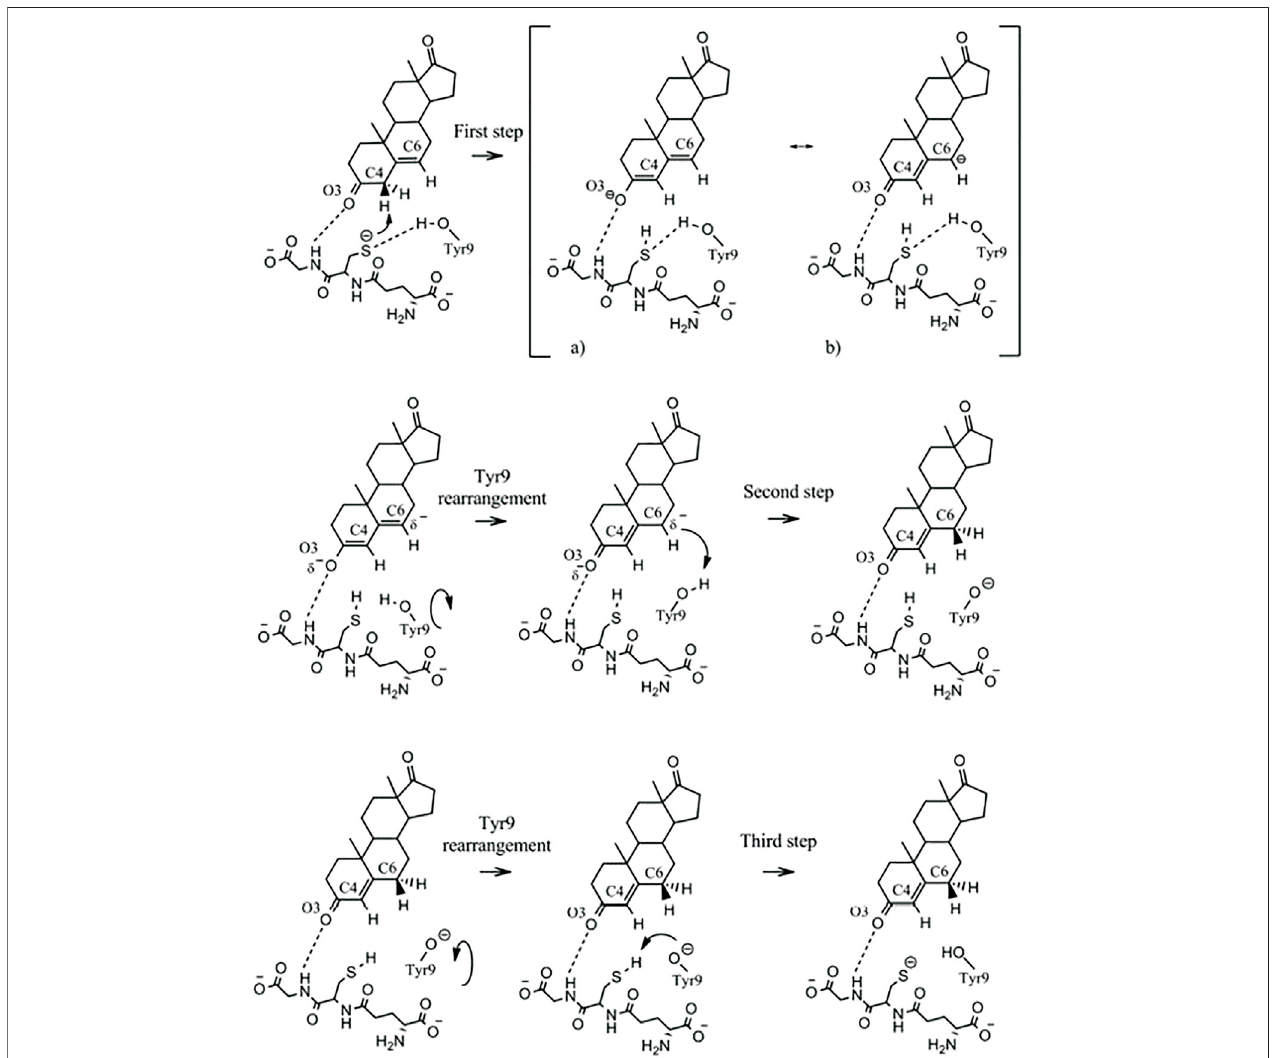
FIGURE 3 | Mechanism proposed for the isomerization of 5-androsten-3,17-dione by GST A3-3. Formation of the thiolate, which acts as a base, requires the α -carboxylate ofGluintheglutathionemolecule. TheNH ofGlyinglutathionepolarizestheO (cid:2) C3bondofthesteroid.ThehydroxylgroupofTyr9intheactivesiterotates between the sulfur of glutathione and C6 of the steroid substrate and serves as an acid in the catalysis. (Figure with permission from Dourado et al., 2014).